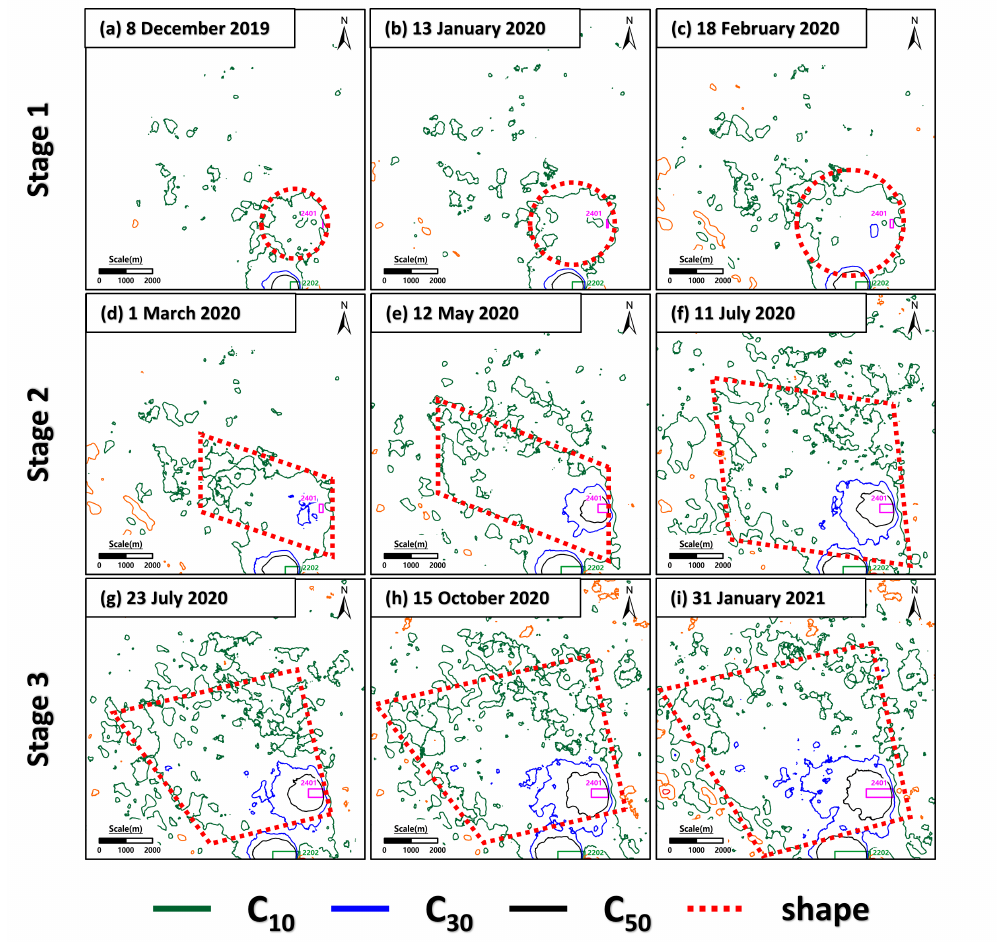
Figure 12. Variations of the surface subsidence basin shape during the mining activities of the 2401 working face. Subfigures ( a – i ) show the surface subsidence basin shape at different dates. The shapes of C 30 and C 50 were less variable, being circular first and then oval.